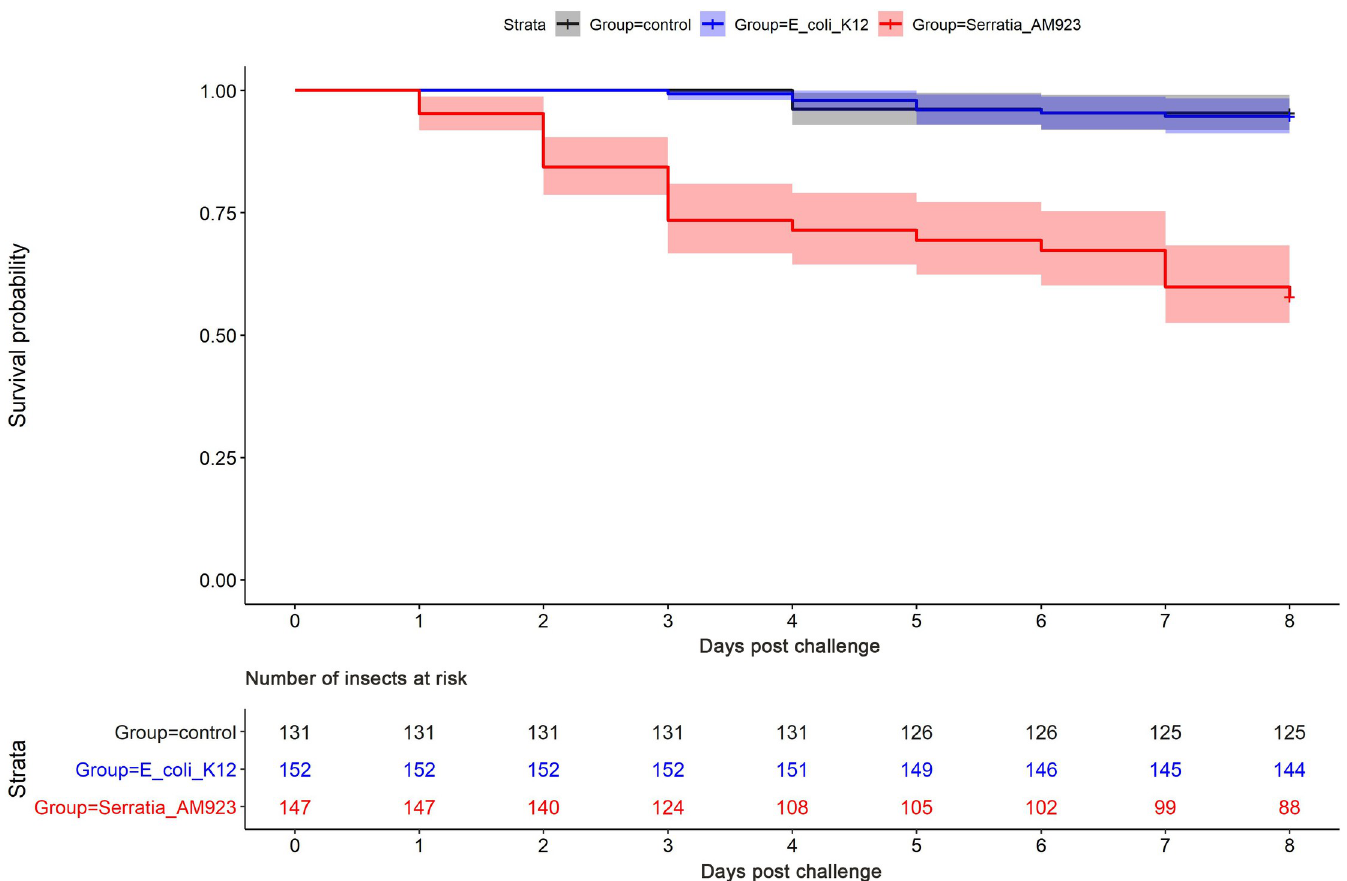
Fig 6. Kaplan-Meier survival curves in honey bees challenged with a live culture of S . ureilytica . Strain AM923 (red), E . coli K12 (blue), or exposed to sterile PBS and the sucrose/water mix as uninoculated negative controls (dark grey). Semi-transparent zone indicates a 95% confidence interval.